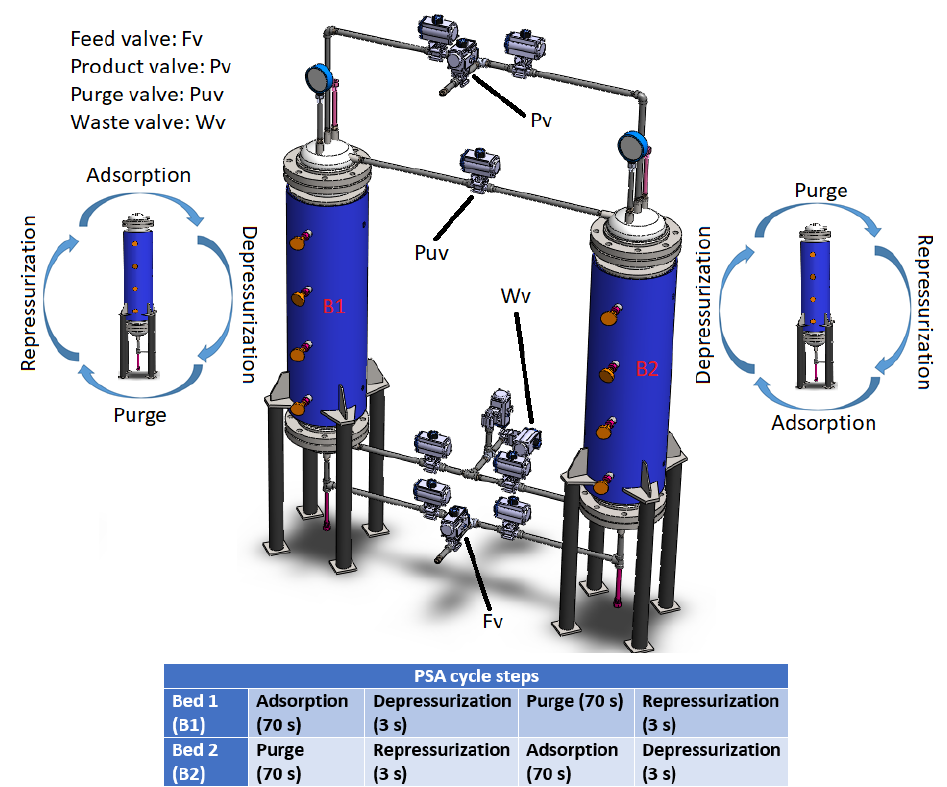
Figure 1. PSA schematic diagram with nominal operating